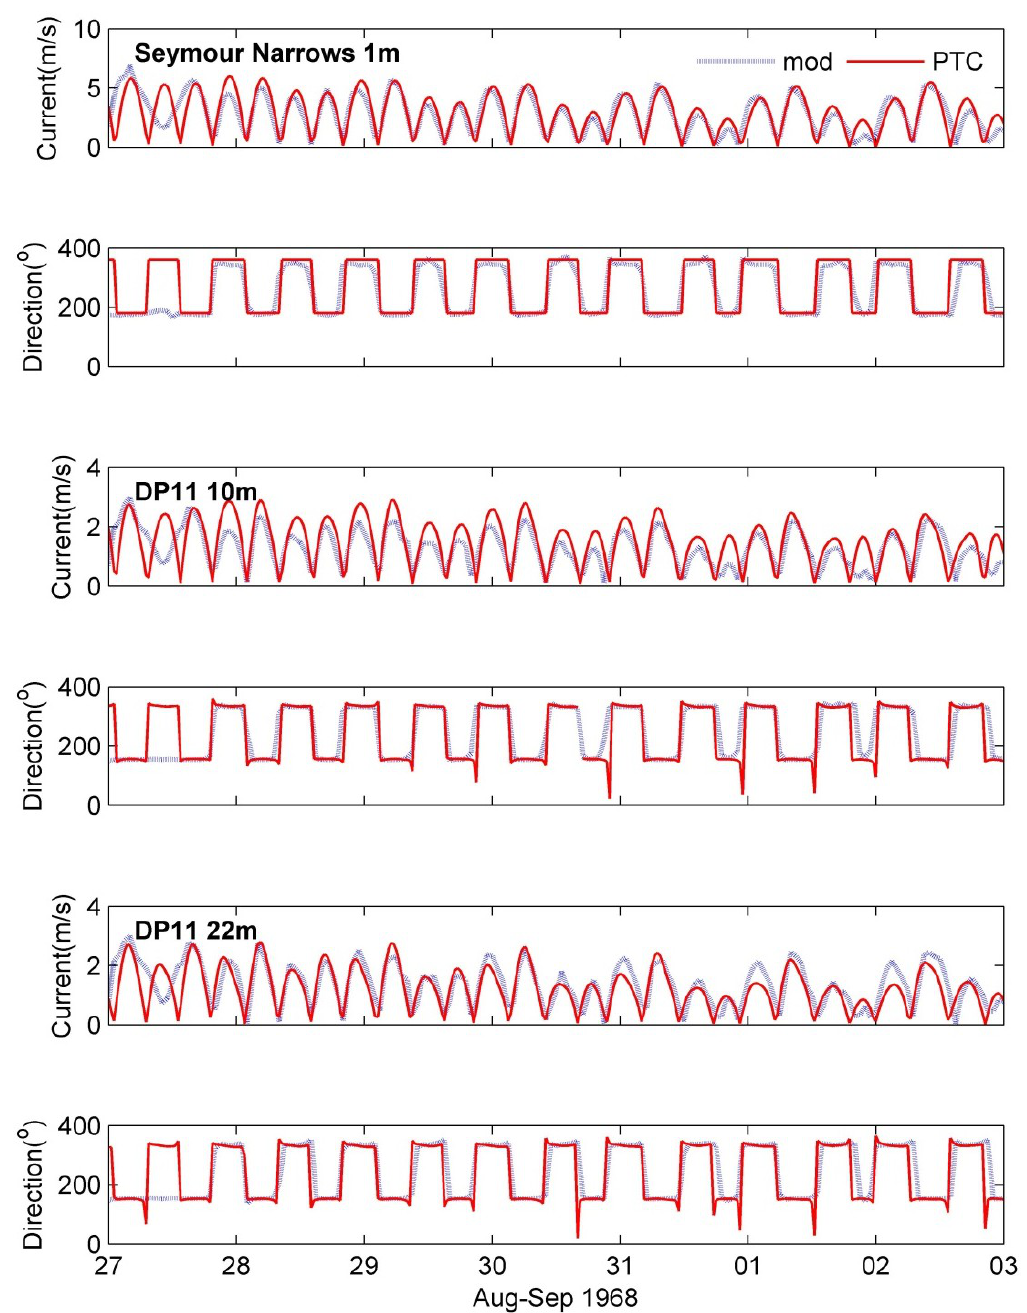
Figure 7. Model (mod, gray lines) generated current speeds and directions (clockwise from North) at Seymour Narrows (at 1 m depth) and DP11 (at 10 m and 22 m depths separately) as marked in Figure 1, with comparisons to Predicted Tidal Currents based on IOS current meter measurements (PTC, red